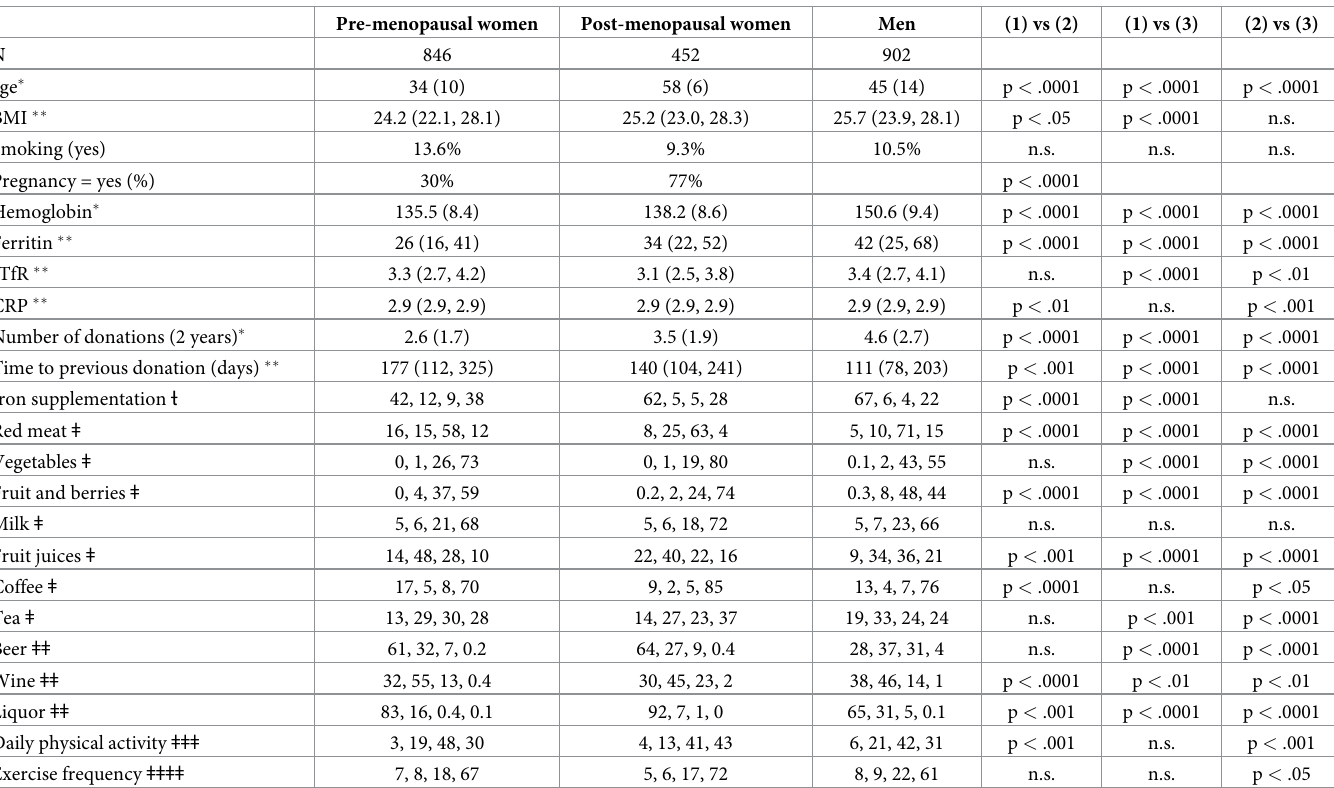
Table 1. Basic characteristics of study